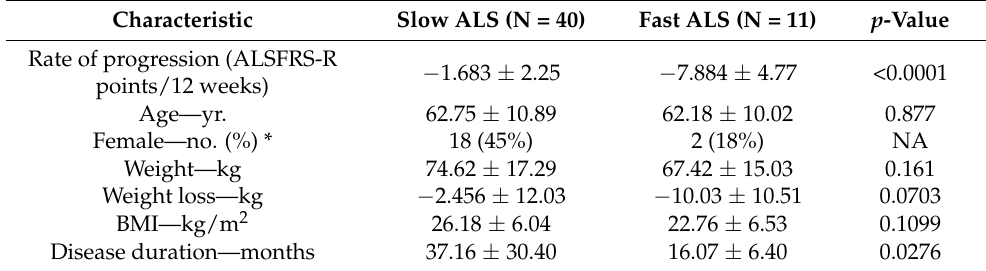
Table 2. Clinical characteristics of slow and fast